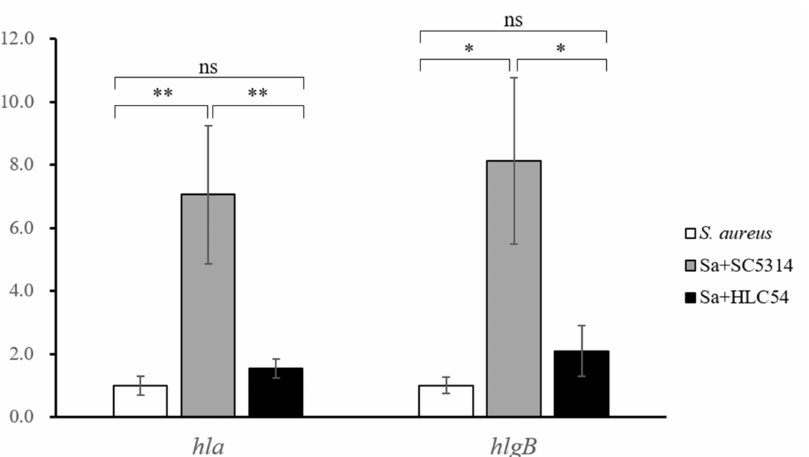
Figure 5. The upregulation of S. aureus toxin genes hla and hlgB in a mixed biofilm that is formed by S. aureus and C. albicans SC5314. After 24-h maturation of biofilms on filter membranes, the in vitro biofilms that were formed with S. aureus only (SA, white bars), S. aureus co-cultivated with C. albicans SC5314 (SA + SC5314, gray bars), or with hyphae-defective mutant HLC54 (SA + HLC54, black bars) were washed twice, and total RNA was isolated and reverse transcribed to determine gene expression. Note: * p < 0.05, ** p < 0.01, ns = not